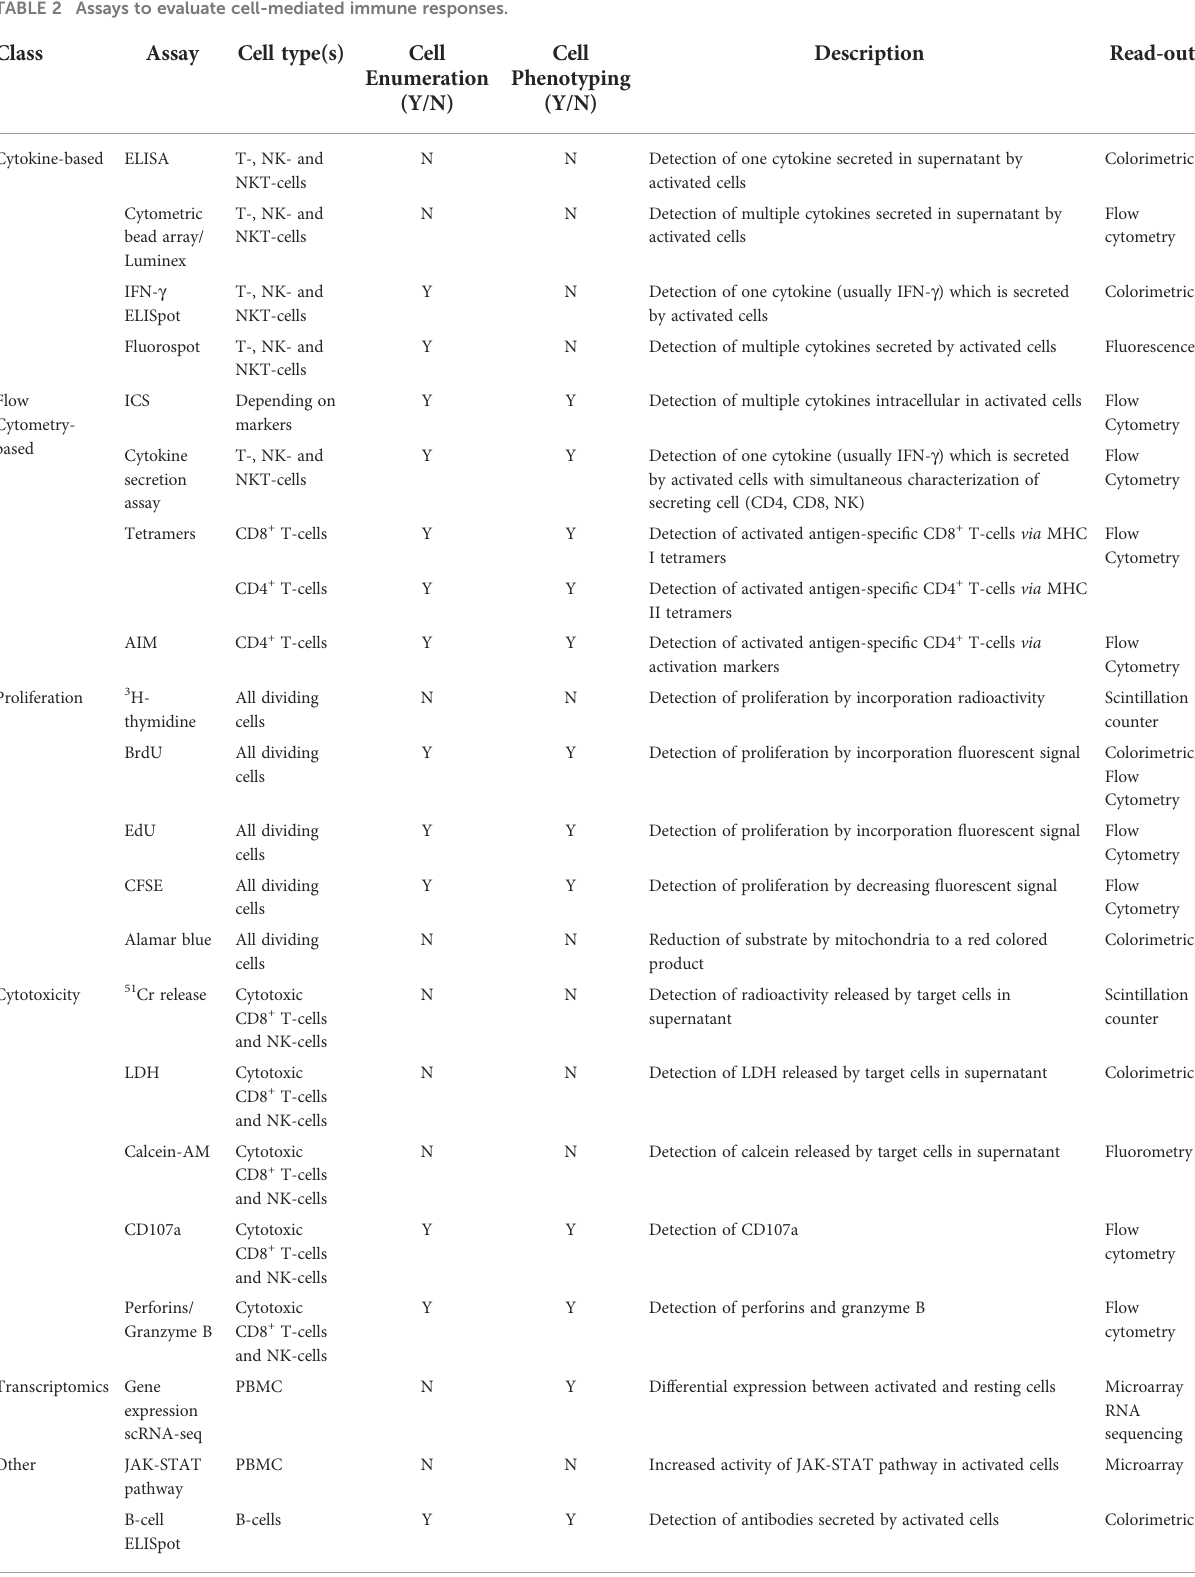
TABLE 2 Assays to evaluate cell-mediated immune